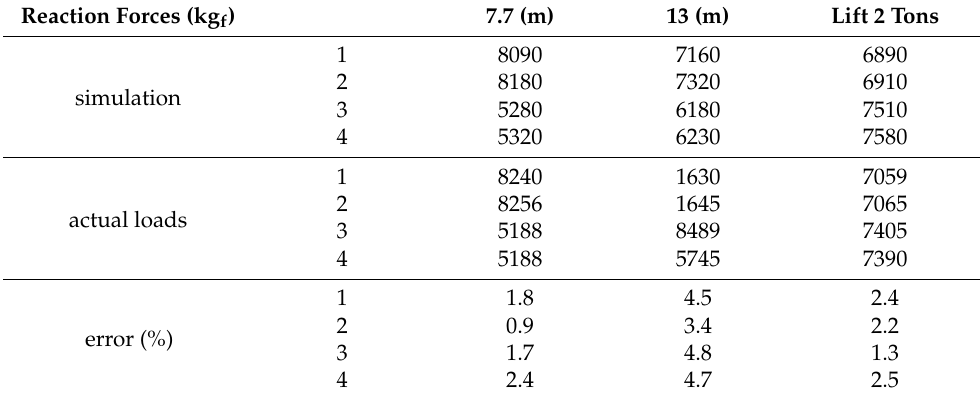
Table 4. Comparison between the simulation result and actual load of reaction force.